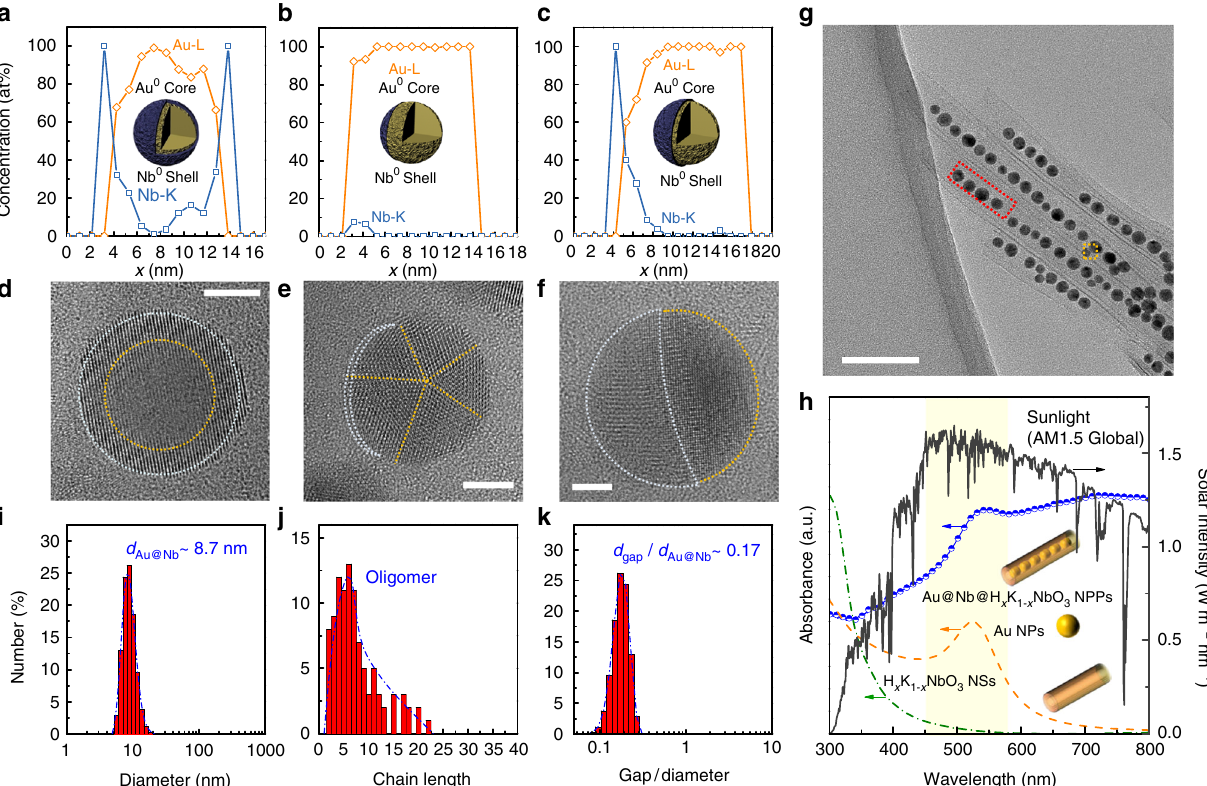
Fig. 2 CS-NP con fi guration and con fi guration-dependent surface plasmon resonances of the Au@Nb@H x K 1 − x NbO 3 NPPs. a – c EDXS line pro fi les (element contributions from the H x K 1 − x NbO 3 NSs were subtracted) and d – f corresponding HRTEM images reveal the CS-NP con fi guration of the Au@Nb@H x K 1 − x NbO 3 NPPs. Orange and white dashed lines in the HRTEM images delineate core and shell boundaries (lines are guide to the eye) of single-crystalline Au@Nb CS-NPs with a continuous Nb shell ( a , d ) (scale bar: 4nm); multiply twinned Au NPs with thin incomplete Nb shells ( b , e ) (scale bar: 3nm); Au@Nb CS-NPs with